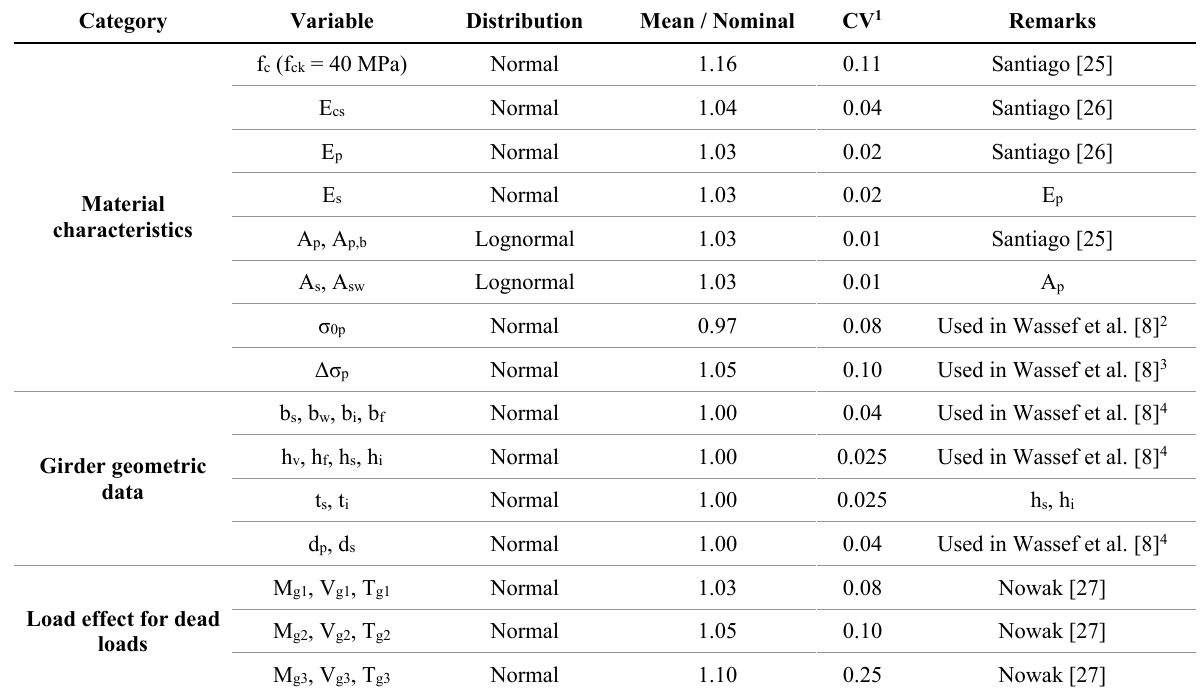
Table 6. Random variables (indicated in Figure 10 and Section